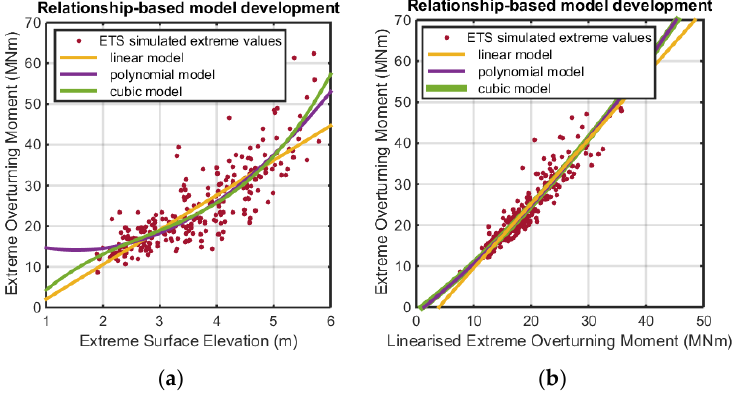
Figure 5. ( a ) ETS-Reg SE model based on the ETS-R SE relationship. ( b ) ETS-Reg LR model based on the ETS-R LR relationship. For the cases of total quasi-static overturning moment responses, H s = 5 m, T z = 7.94 s, and U = 0 m/s. ( a ) ETS-R SE and its ETS-Reg SE model. ( b ) ETS-R LR and its ETS-Reg LR model. Table 2. Types of ETS-Reg models regarding the coefficient of determination for the low and high sea state ( H s ) conditions without current ( U = 0.0 m/s) impacts regarding total quasi-static base shear and overturning moment